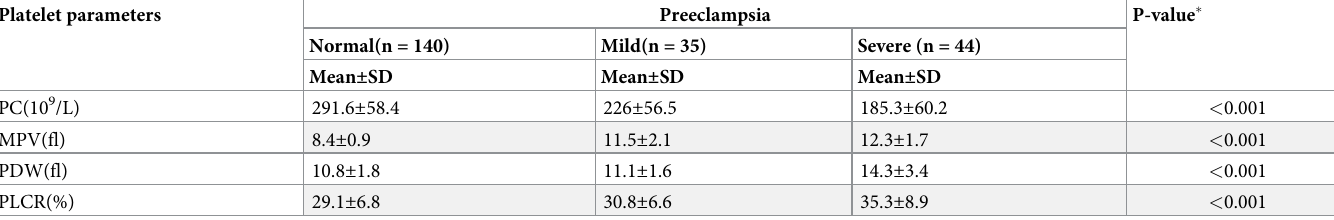
Table 2. Comparison of platelet parameters by severity of PE among pregnant women attending ACSH and MGH, Mekelle, Ethiopia, January-March 2017 (n = 219). Platelet parameters